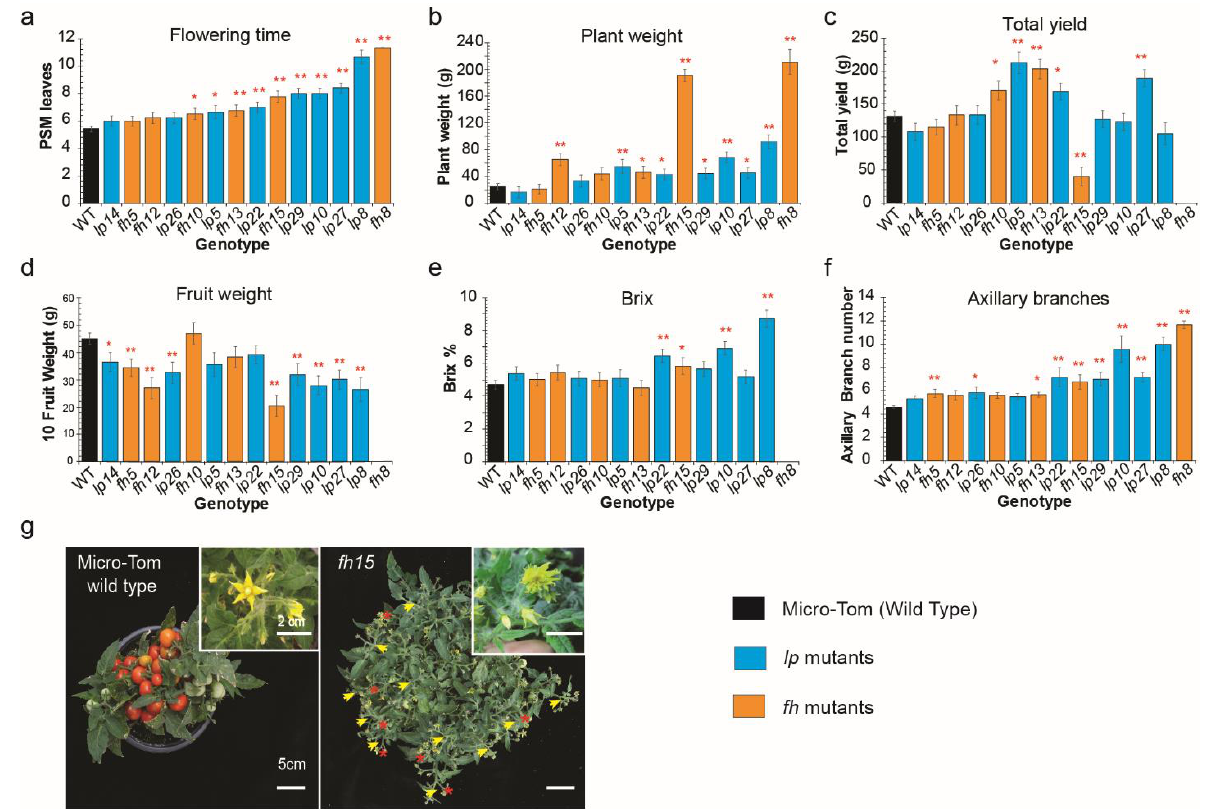
Figure 5. Exploring yield dynamics determining the relationship with the late-flowering continuum with lp and fh mutants. Statistical comparison of leaf numbers ( ± s.e.m) indicating the flowering time of mutants and arrangement in ascending order of flowering time ( a ). ( b – f ) Statistical comparisons of the value of plant weight ( b ), total yield ( c ), fruit weight ( d ), Brix value ( e ), and axillary branch number ( f ). Representative images of Micro-tom shoots and flowers ( left ) and fh15 plant with fasciated flower and increased inflorescence indicating the higher branching was not compensated by the flowering time. Fasciated flowers and inflorescence were magnified in white line box ( g ). Yellow arrowheads indicate branches on the inflorescence. Red asterisks indicate fasciated flowers. Mean values (±s.e.m.) were compared to those for wild-type and late-flowering mutants using Student’s t -tests (* p < 0.05, ** p < 0.01). Multiple-comparison analyses were also conducted using Tukey–Kramer test ( p < 0.05; Table S3).